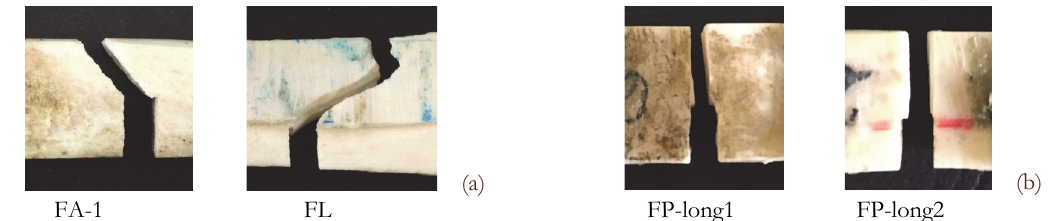
Table 1: Elastic modulus and fracture toughness.